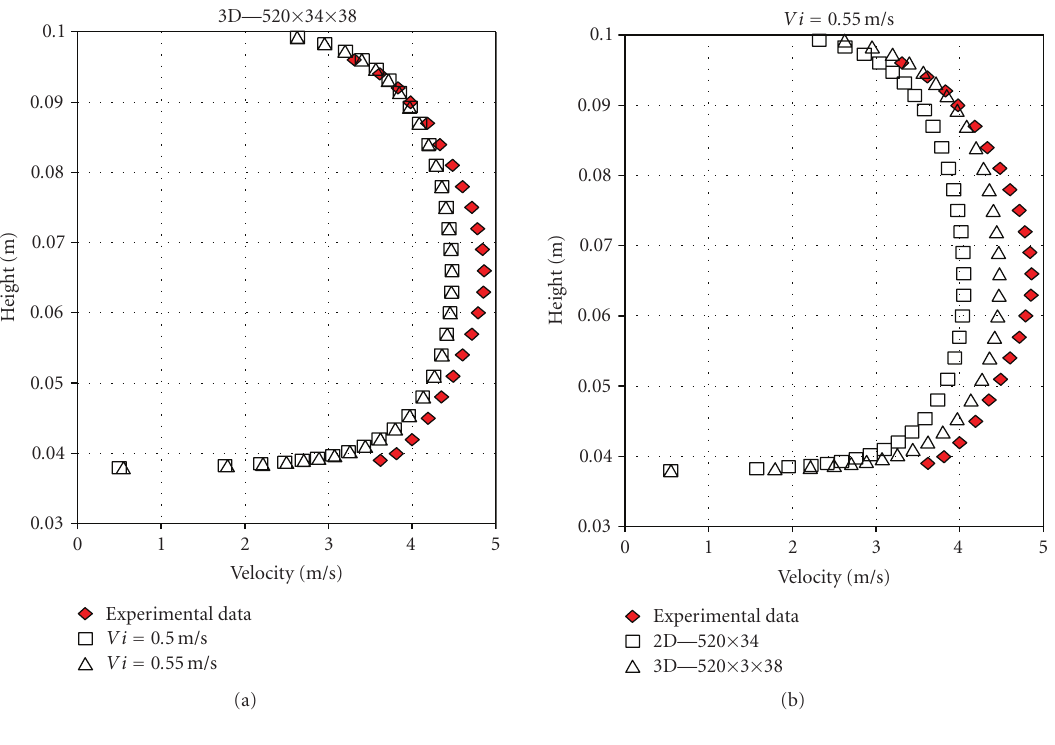
Figure 6: Air velocity: (a) 3D grid with di ff erent interface velocities; (b) 3D versus 2D.